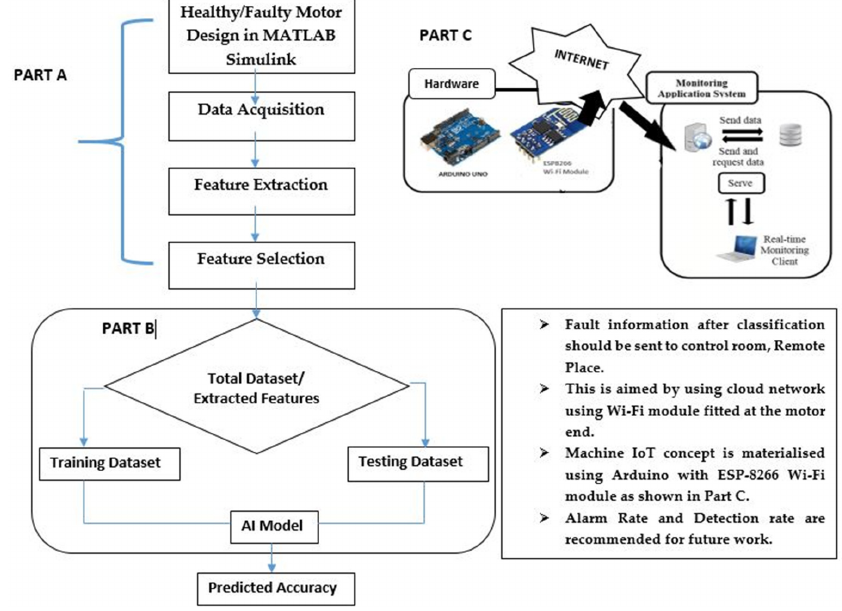
Figure 3. Proposed Algorithm Flowchart (Quality Improved also enlarged-300